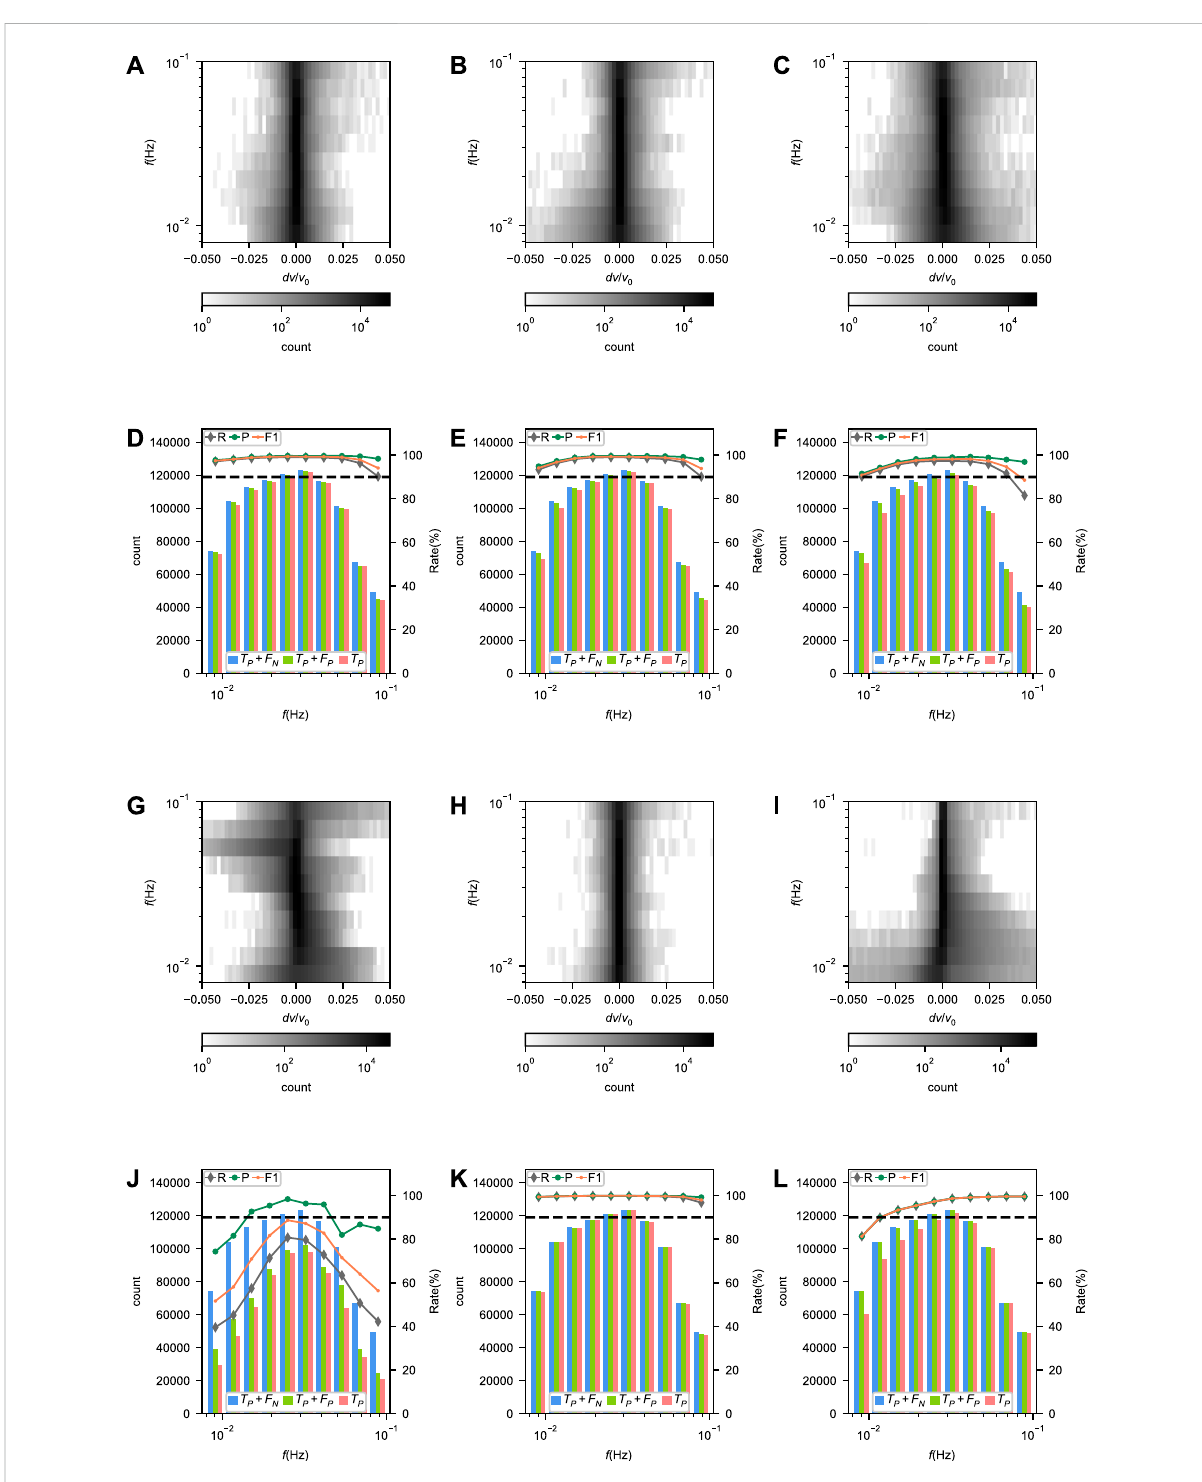
FIGURE 8 (A – C) and (G – I) Error distributions and (D – F) and (J – L) performances of Surf-Net (A, D) , Surf-Net_noDis (B, E) , Surf-Net_small (C, F) , Surf- Net_obs (G,J) ,surf-Net_syn (H,K) andMFT (I,L) atdifferentfrequenciesforthesinglepicksinthesynthetictestset.In (A – C,G – I) ,theshadesofgrey show the number of picks with close measurement errors for the same frequency. In (D – F, J – L) , the histograms represent the values of T p , T p + F p and T p for different frequencies corresponding to the left vertical axes. The lines of three colors respectively represent the recall, precision and F1 corresponding to the right vertical axes. The black dashed line shows the rate of